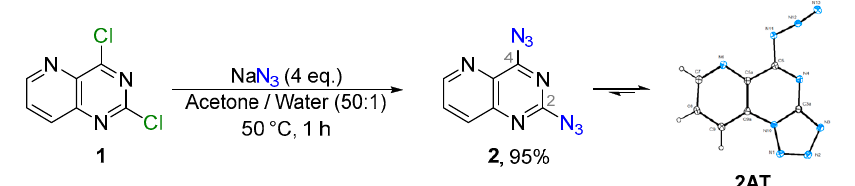
Figure 1. ( a ) Azide-tetrazole equilibrium; ( b ) reactivity of 2,4-diazidopyrimidines; ( c ) S N Ar regi- oselectivity in fused